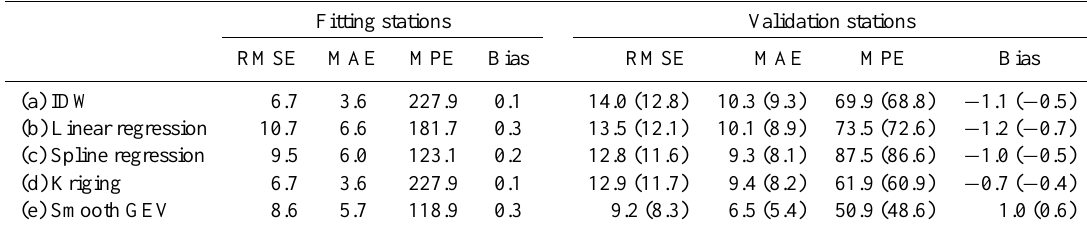
Table 3. Scores of quantile comparison when using a DEM and the mean snow depth as covariates. For the validation stations, either the kriged mean snow depths or the observed mean snow depths (scores in brackets) are used. Methods (a) to (d) are interpolation methods of Sect. 5. Method (e) refers to Sect.